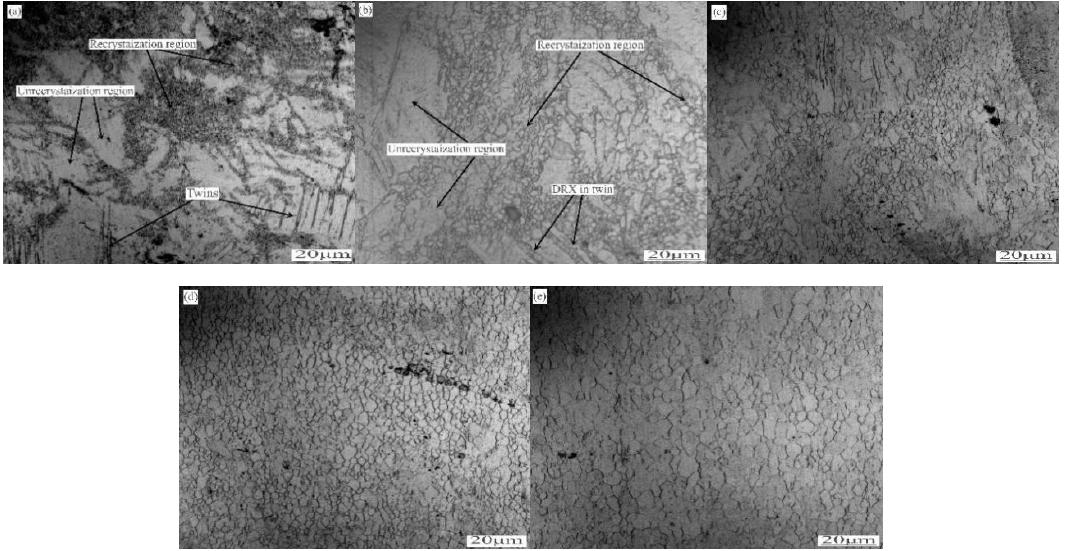
Figure 3. Optical images of the ZK60 magnesium alloy after HSRR under different strain rates. ( a ) 5 s −1 ( b ) 10 s −1 ( c ) 15 s −1 ( d ) 20 s −1 ( e ) 25 s −1 .